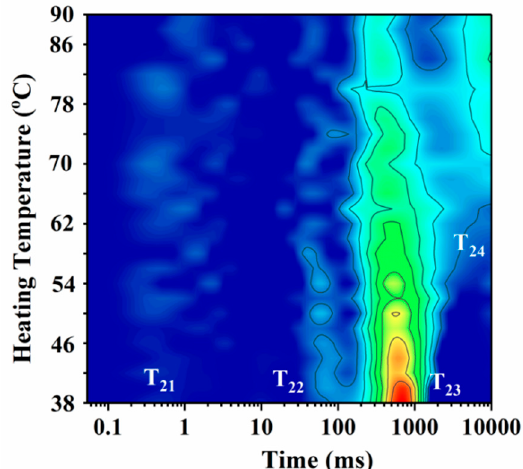
Figure 2. Moisture distribution change of MP-only system by adding 20% ( v / v ) distilled water at various temperatures.